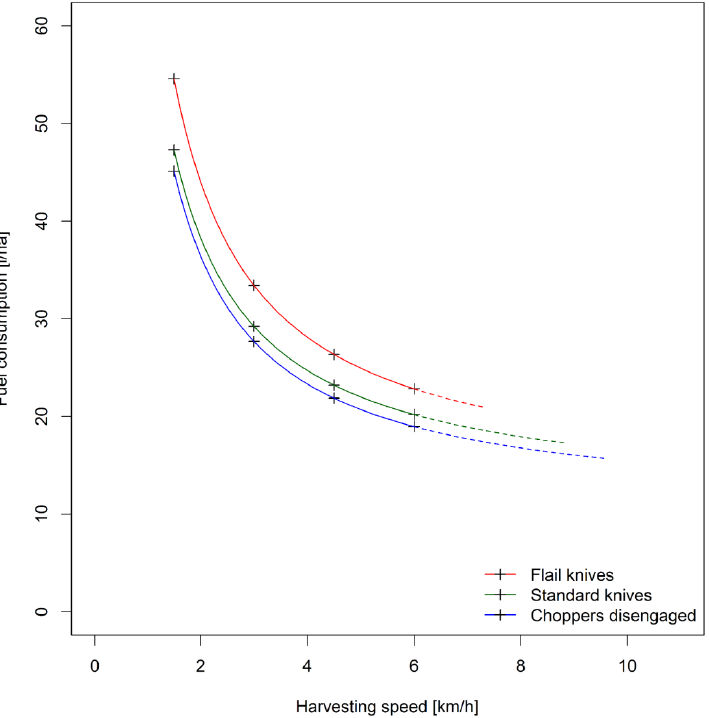
Figure A11. Fuel consumption of the combine harvester depending on harvesting speed for the levels of corn header configuration at cutting height level 4 (Markers indicate harvesting speed levels at cutting height level 4, dashed lines represent extrapolation up to a theoretical engine load of 90%).